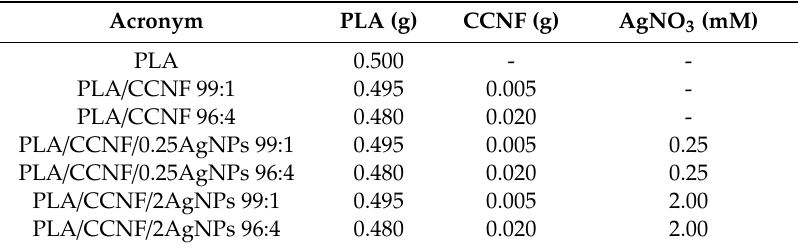
Table 1. Weight proportions of PLA, CCNF, and AgNPs in each composite. In this table, the initial concentration of AgNO 3 in nanocellulose dispersion is